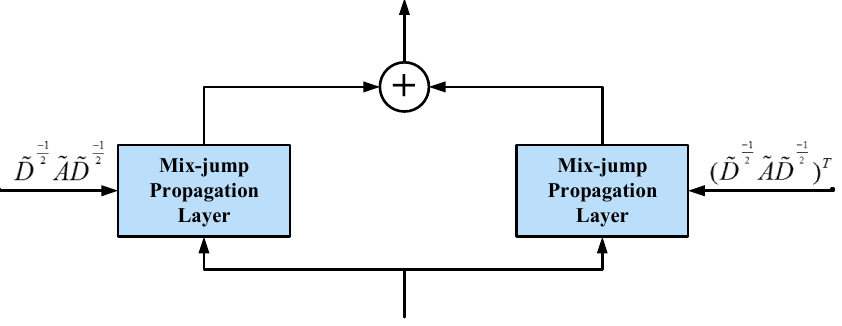
Figure 2. Graph convolution module structure.